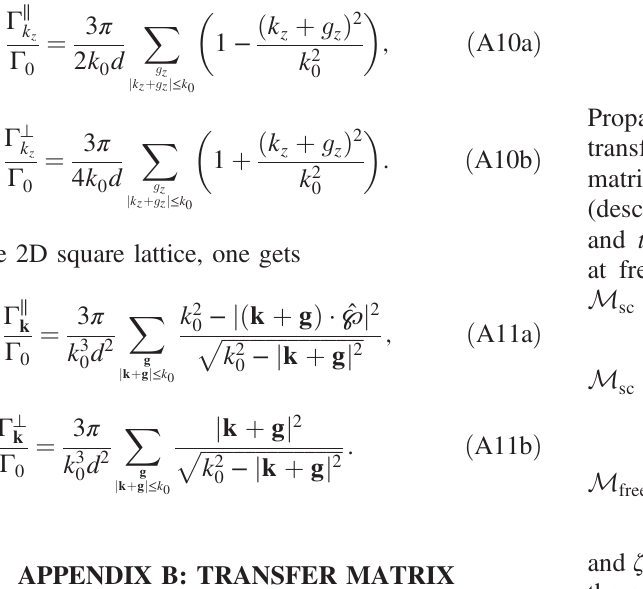
relates the fields on one sc are sc M N N ¼